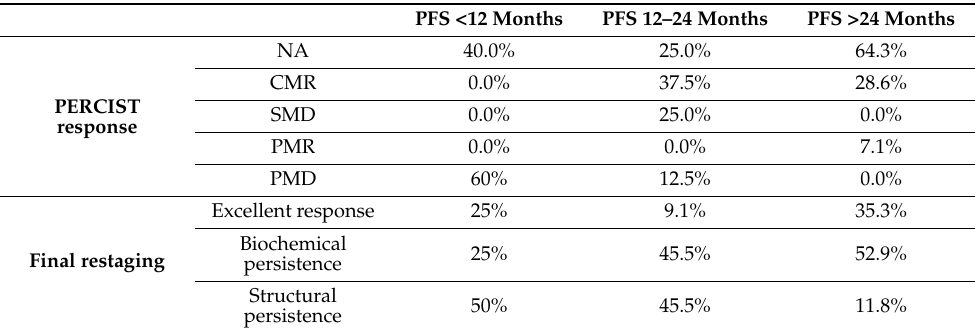
Table 7. Association between PFS range, PERCIST response, and final restaging